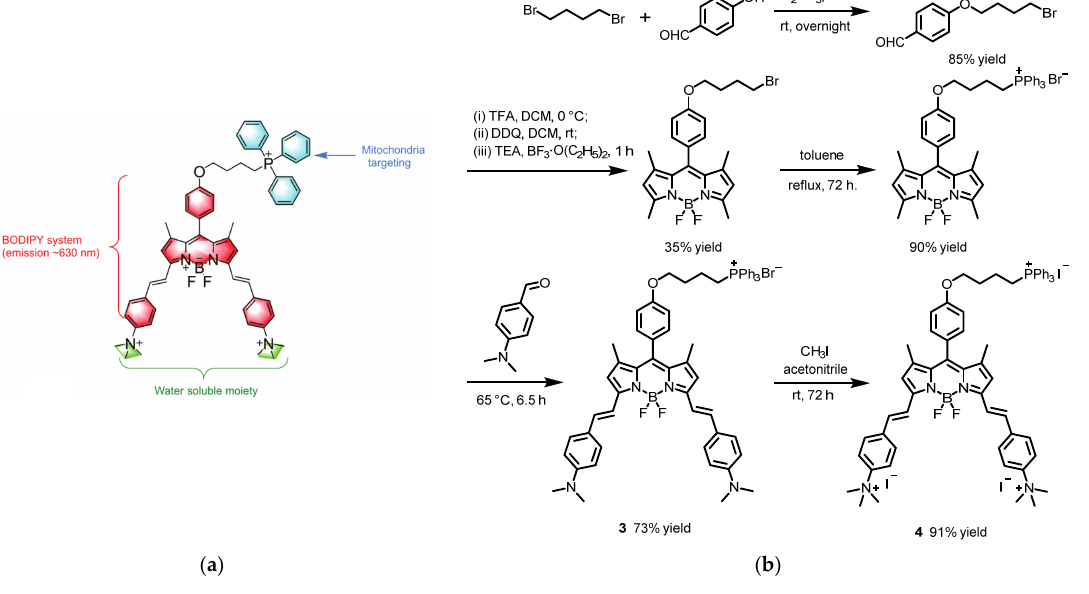
Figure 4. Confocal microscopy colocalization images of HeLa cells stained with BODIPYs 3 and 4 , and MTG. ( a , d ) MTG under a green channel (488 nm), ( b , e ) BODIPYs 4 and 3 under a red channel, and ( c , f ) merged images. Adapted from [21].